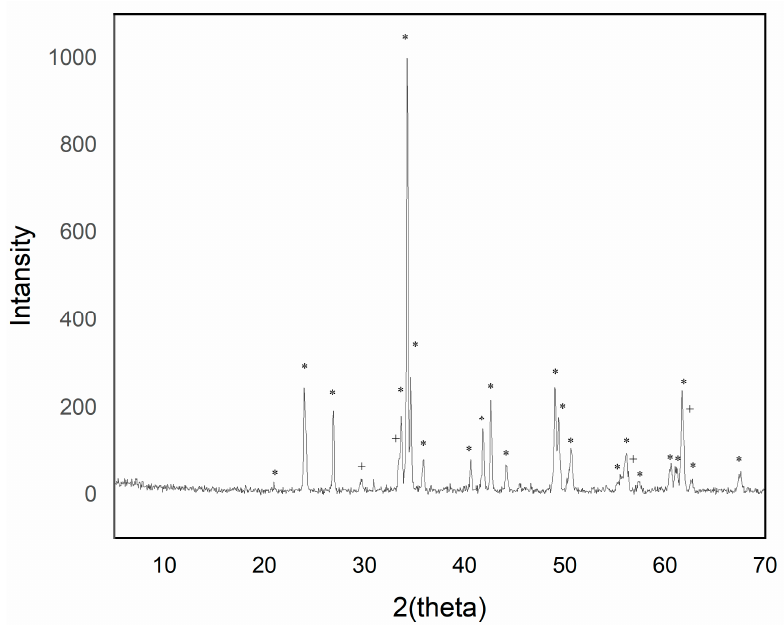
Figure 5. XRD of sample Y 0.90 AlCr 0.10 O 3 1500 °C/6 h with 5% w / w CaF 2 addition (+ garnet Y 3 Al 5 O 12 phase; * perovskite YAlO 3 phase).